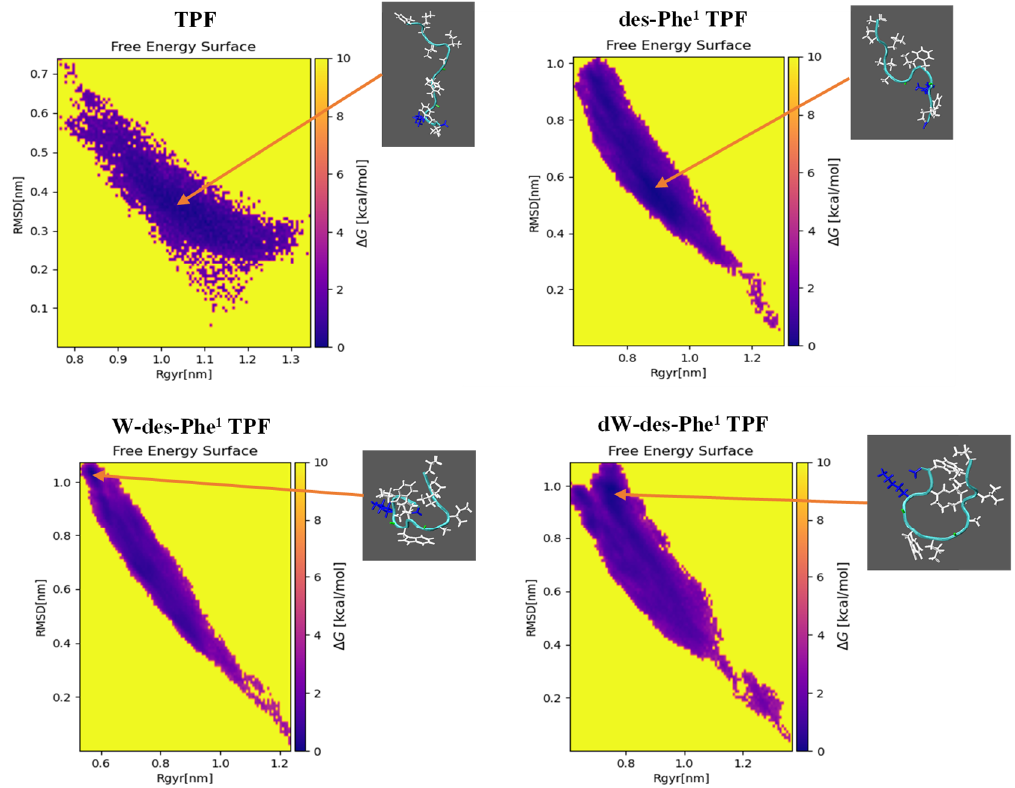
Figure 4. The plot of the free energy of each MD trajectory frame of the folding of TPF and the analogs for 100 ns simulation in a water box, in terms of RMSD and Rgyr from a linear extended structure. Arrows indicate the represented frames with the lowest free energy.